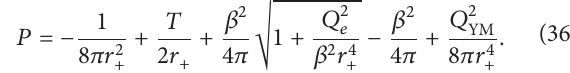
thermal behavior of “ideal gas.” The dashed line is the isobar of 𝑃 = 𝑃 𝑐 . The solid line is the isobar of 𝑃 < 𝑃 𝑐 ; one can see that there are two branches of black holes whose